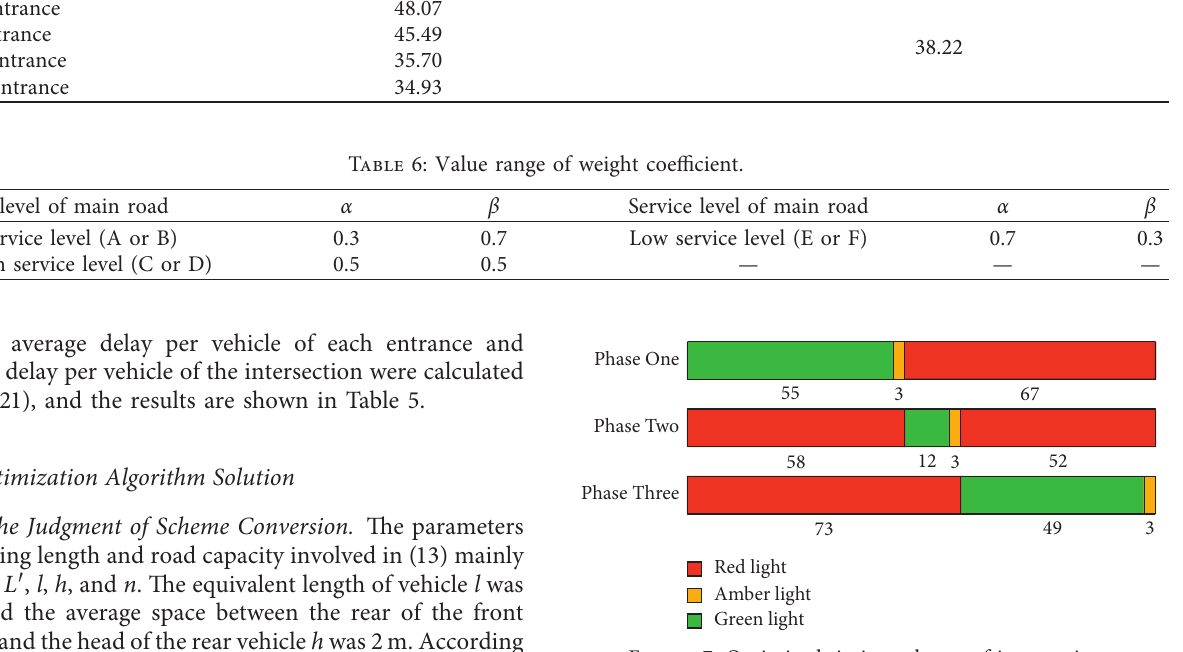
Figure 7: Optimized timing scheme of